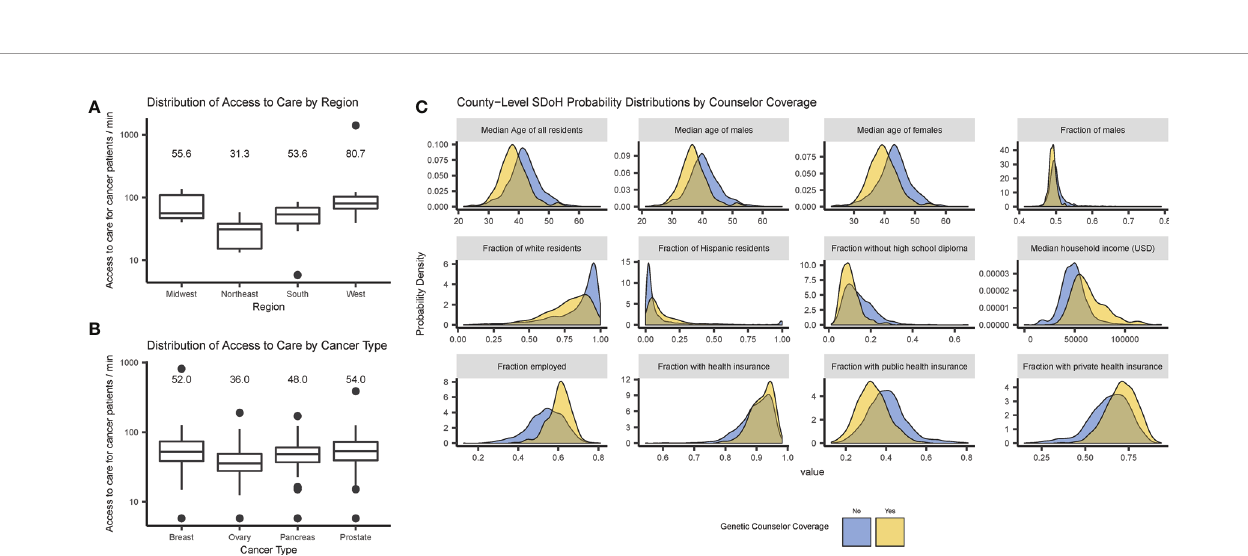
FIGURE 2 | Disparities in access to care by cancer patients and genetic counselor access: (A) box plots of access metric by U.S. Census region; (B) box plots of access metrics by cancer type; and (C) probability densities of county-level SDoH distributions by genetic counselor access. Note that in (A, B) , state-level access (de fi ned as the median drive time for a cancer patient to a genetic counselor) is plotted on a log axis, and the medians are provided as labels.